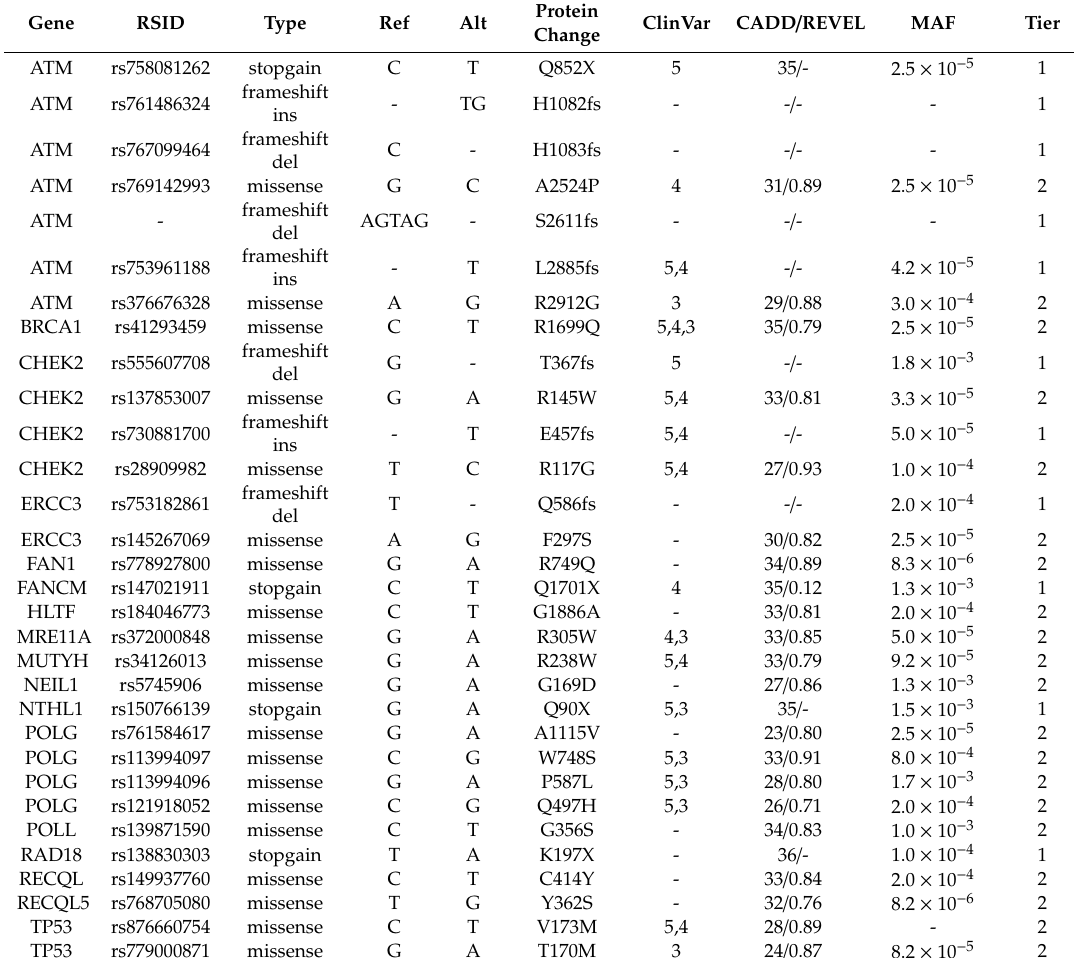
Table 2. Potentially damaging mutations identified in men with lethal prostate